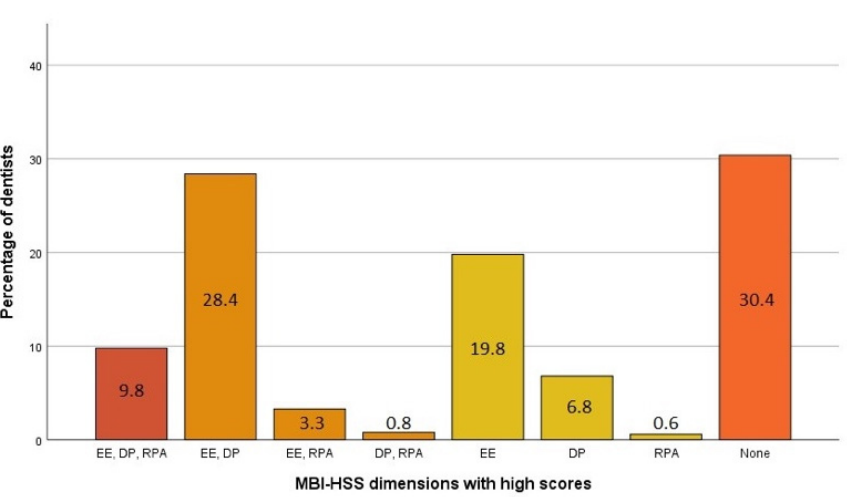
Figure 1. Distribution of dentists participating in our study according to burnout dimensional scores. (MBI-HSS). Emotional exhaustion (EE), depersonalization (DE), and reduced personal accomplishment (RPA).